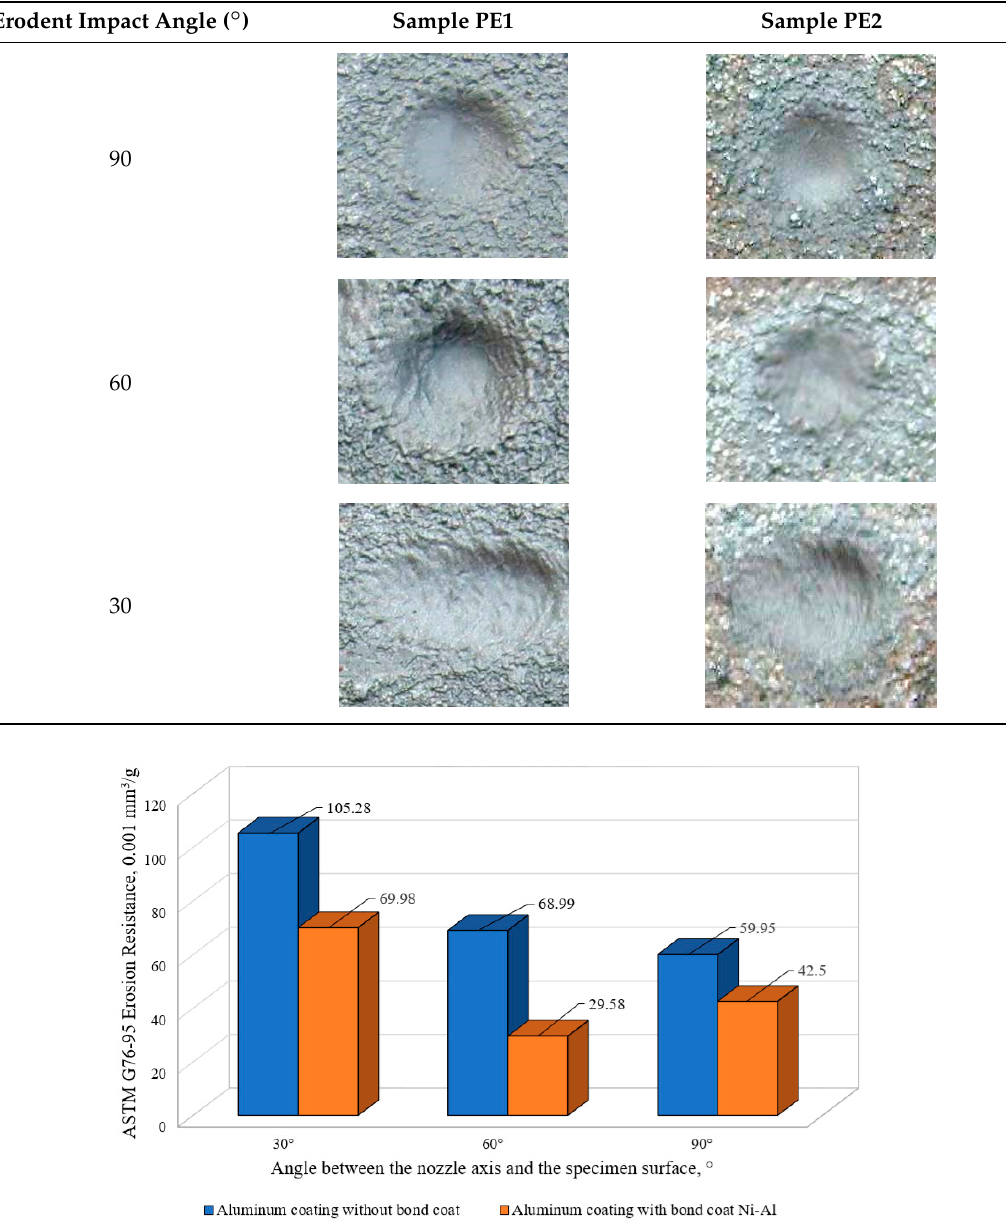
Figure 7. Results of erosion resistance tests for investigated materials and different erodent impact Figure angles. Table 4. PE1 and PE2 samples after erosion test, comparison of erodent effect on the sample surfaces for each of the angles studied.